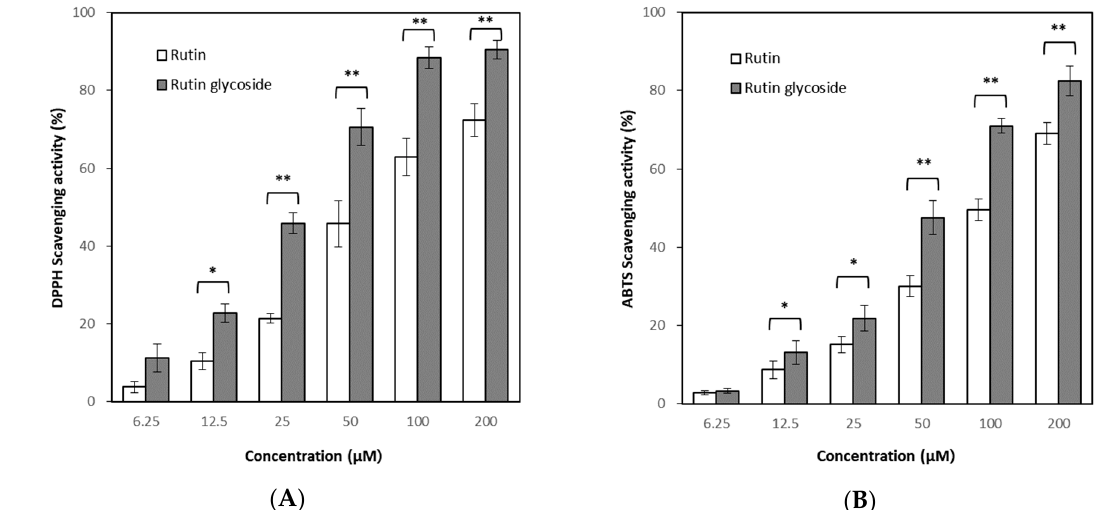
Figure 4. Antioxidant activity of rutin and rutin glycoside. Result expressed as a mean ± SD ( n = 3). ( A ) 1,1-diphenyl-2-picrylhydrazyl (DPPH) scavenging assay, ( B ) 2,2 ′ -azino-bis-3-ethylbenzthiazoline-6-sulphonic acid (ABTS) scavenging assay. Significant differences were found between the rutin and rutin glycoside (* p < 0.05, ** p < 0.01).